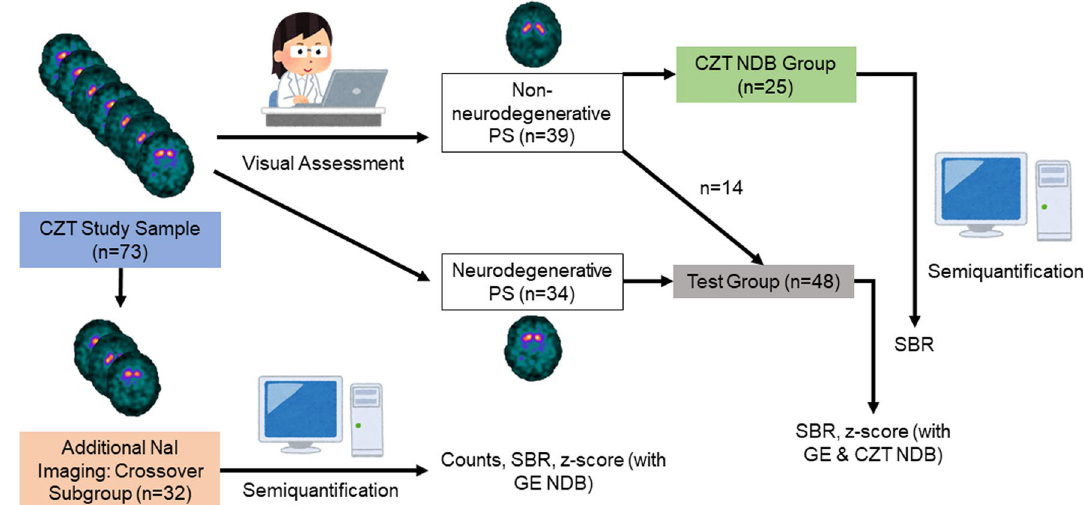
Fig. 1 Flowchart of study design and composition of subgroups